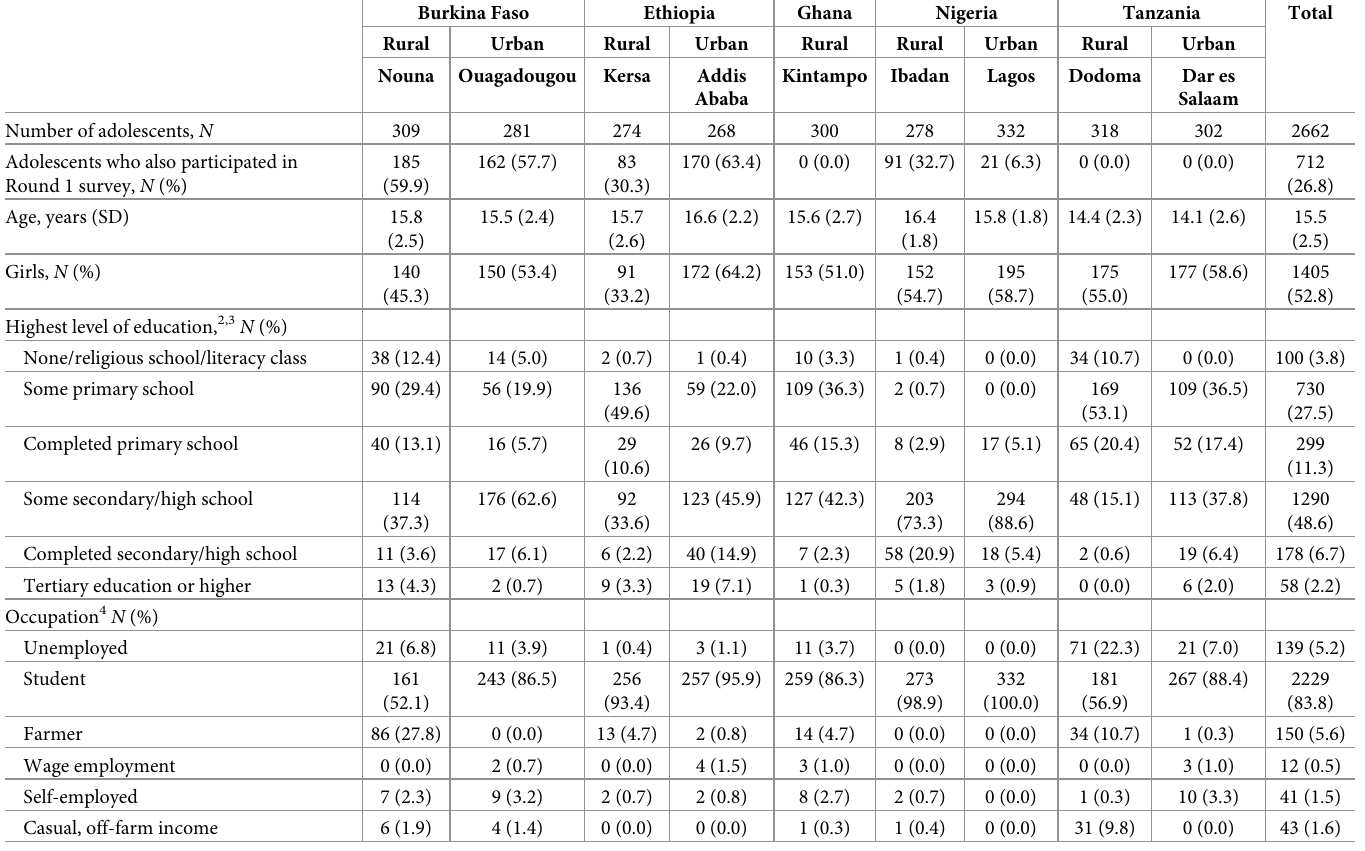
Table 1. Sociodemographic characteristics of adolescents in a phone-based survey in five sub-Saharan African countries, 2021 1 . Burkina Faso Ethiopia Ghana Nigeria Tanzania Total Rural Urban Rural Urban Rural Rural Urban Rural Urban Nouna Ouagadougou Kersa Addis Kintampo Ibadan Lagos Dodoma Dar es Ababa Salaam 309 185